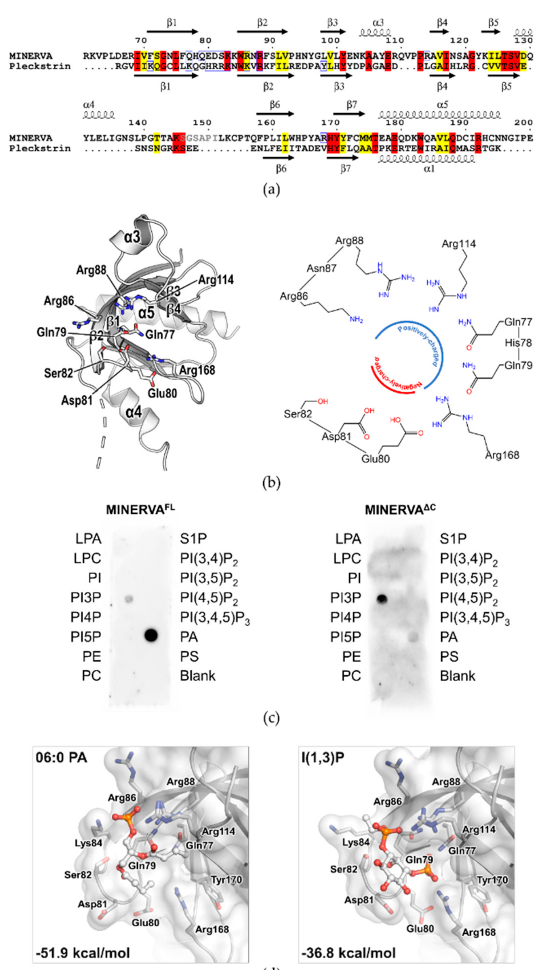
Figure 3. The PH domain of MINERVA. ( a ) Structure-based sequence alignment of PH domains from MINERVA and Pleckstrin (PDB ID: 2I5F) showing conserved residues at the ligand binding site. Conserved residues and similar residues are highlighted in red and yellow, respectively. Residues contributing to ligand recognition are indicated with blue frames. Secondary structure elements of the MINERVA and Pleckstrin models are shown above and below the alignment, respectively. Unmodeled residues (Ser146–Ile151) of MINERVA due to lack of electron density around the cleavage site are in gray. ( b ) Left, cartoon representation of the PH domain of MINERVA with side chains of putative ligand interacting amino acids shown in stick representation. There are both positively charged and negatively charged residues in the ligand binding pocket. Right, schematic of the residues at ligand binding pocket of MINERVA PH domain showing positively charged and negatively charged faces. ( c ) Lipid dot-blot assay of MINERVA FL (left) and MINERVA Δ C (right). Both MINERVAL FL and MINERVA Δ C are capable of recognizing PA and PI3P, but to different extents. Dotted lipids are as follows: lysophosphatidic acid (LPA), lysophosphatidylcholine (LPC), phosphatidylinositol (PI), phosphatidylinositol (3)-phosphate (PI3P), phosphatidylinositol (4)-phosphate (PI4P), phosphatidylinositol (5)-phosphate (PI5P), phosphatidylethanolamine (PE), phosphatidylcholine (PC), sphingosine 1-phosphate (S1P), phosphatidylinositol (3,4)-bisphosphate (PI(3,4)P 2 ), phosphatidylinositol (3,5)-bisphosphate (PI(3,5)P 2 ), phosphatidylinositol (4,5)-bisphosphate (PI(4,5)P 2 ), phosphatidylinositol (3,4,5)-trisphosphate (PI(3,4,5)P 3 ), phosphatidic acid (PA), andphosphatidylserine(PS).( d )GlideinducedfitdockingresultsoftheheadgroupsofPA(left)andPI3P (right) against the PH domain of MINERVA. Sidechains of residues for lipid binding are indicated in stick and surface representations. Binding free energy for PA and PI3P headgroups calculated by the molecular mechanics–generalized Born surface area (MMGBSA) method is shown,